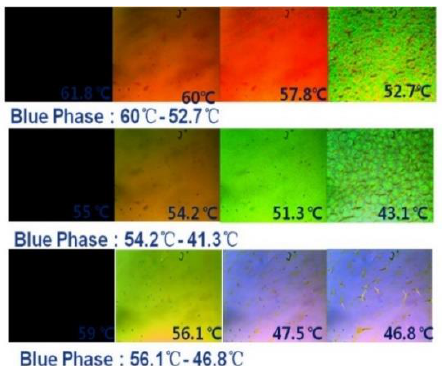
Figure 3. The temperature ranges of the mono-domain blue phase liquid crystal with a red, green, and blue texture.